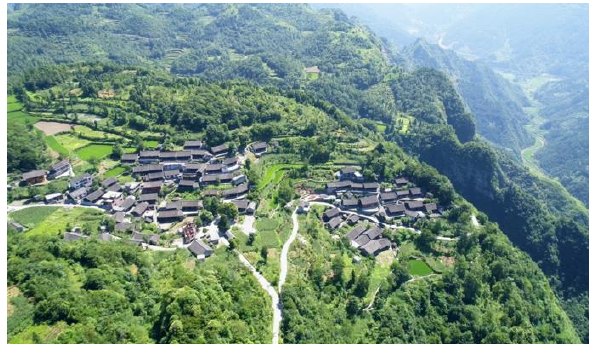
Figure 2. Aerial View of Jinlong